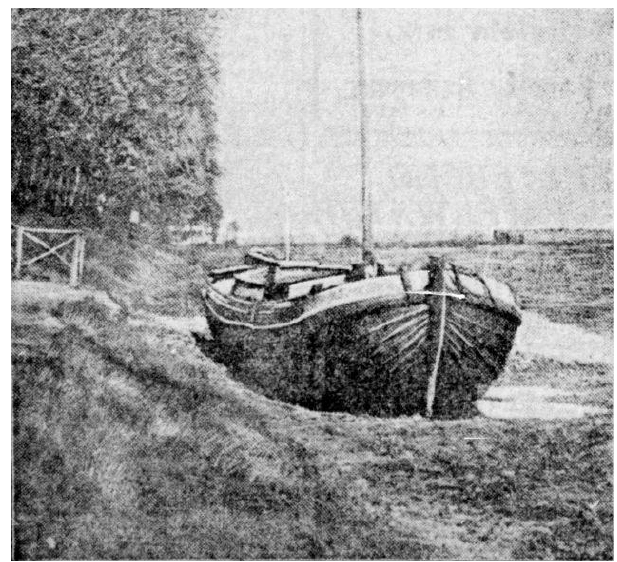
Figure A3. Photograph from the Dutch newspaper De Telegraaf , 1 September 1921. The original caption is “The drought in Fries- land. In Friesland several ships are completely grounded because of the low water level.”